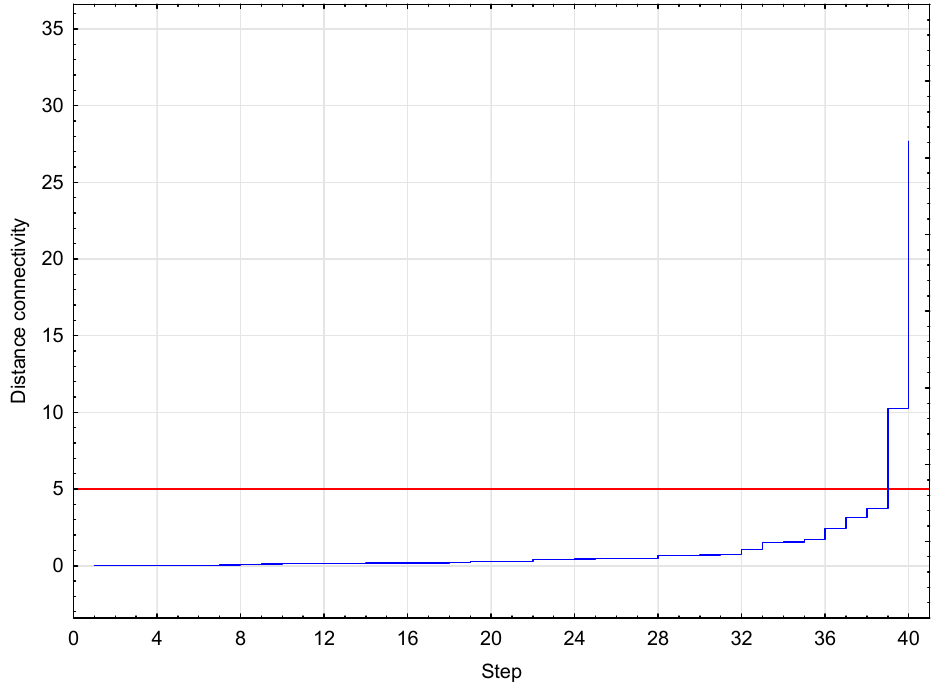
Figure A1. Clustering-over-time graph for the result presented in Figure 14: Agglomerative hierar- chical clustering using Ward's linkage and Euclidean distance. Blue line–Clustering-over-time graph, Red line–shows place where the clusters were split.